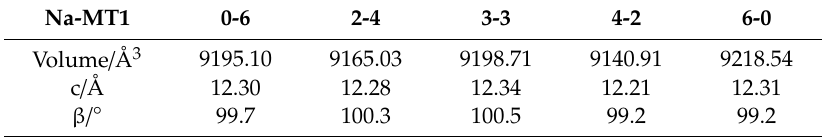
Table 2. The crystal cell parameters of twenty Na-MT models after geometry optimization.